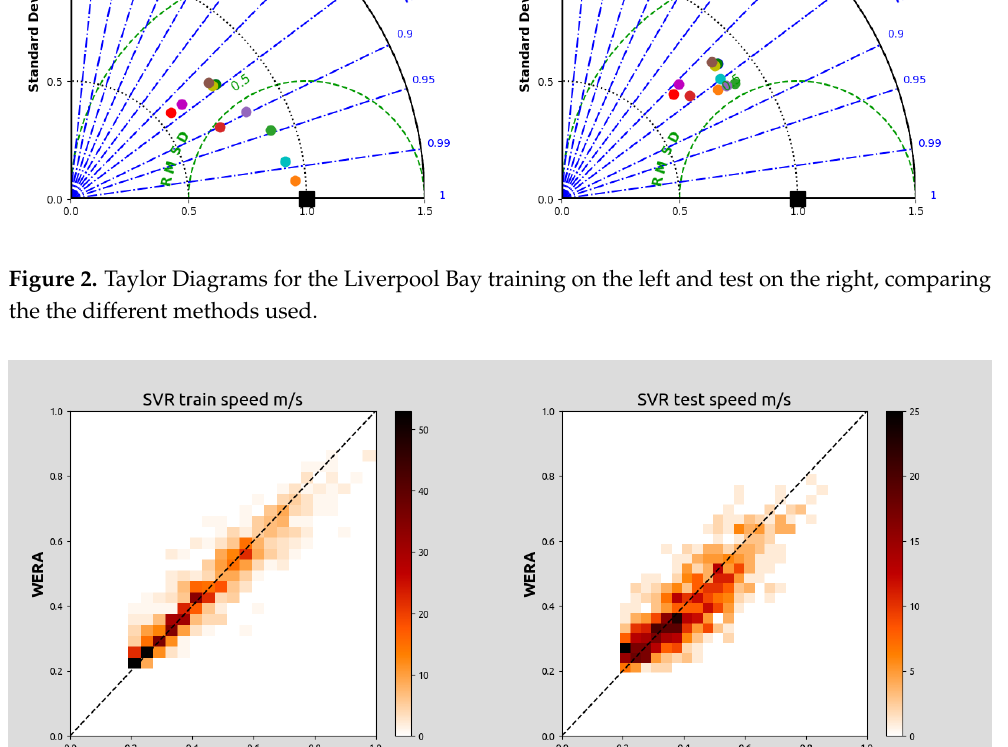
Figure 5. Comparison of north Celtic Sea SVR wind speeds with model speeds. Left: training right: test. Colour-coding is number of cases in each bin. SVR statistical results for all radar sites are given in Table 5. For lb these are calculated